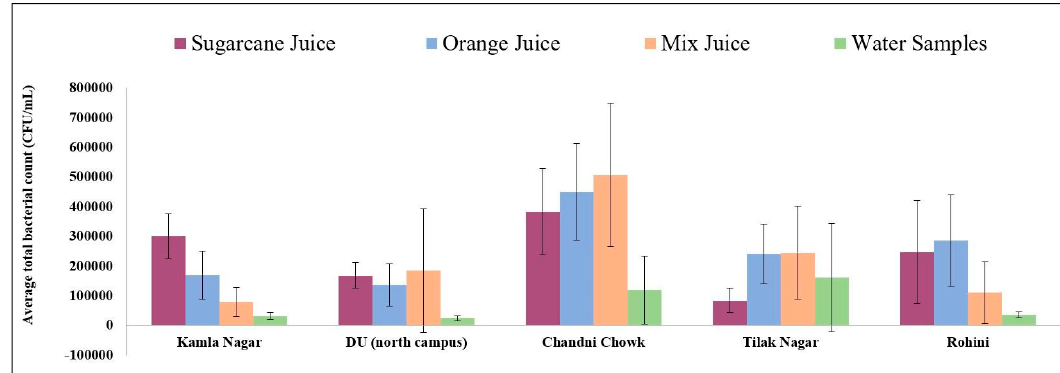
Figure 1. Average total bacterial count (colony forming units (CFU)/mL) in different fruit juices for five most famous markets of Delhi.